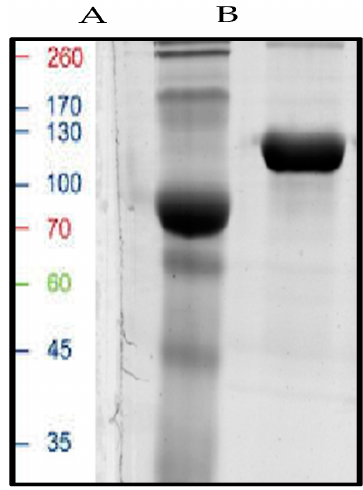
Figure 2. Cropped SDS-PAGE of inuliase enzyme produced by Rhizopus oryzae NRRL 3563. ( Lane A ) standard protein marker. ( Lane B ) SDS-PAGE of the partially purified inulinase enzyme.